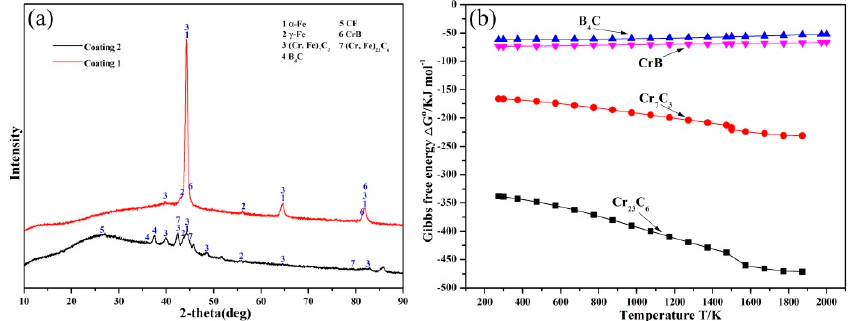
Figure 7. XRD patterns of the composite coatings ( a ) and the Ellingham diagram of Gibbs free energy via the reaction temperature ( b ).